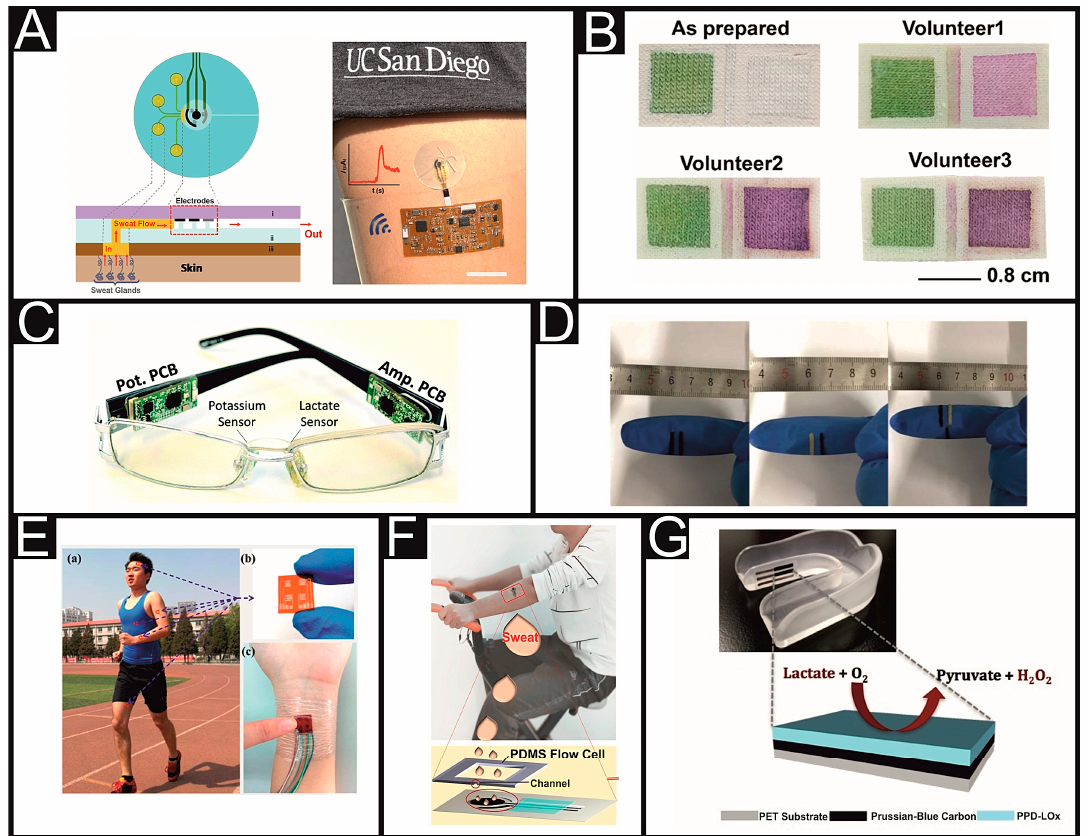
Figure 3. ( A ) Schematic representation and picture of the microfluidic device for the detection of lactate in sweat. Repro- duced/adapted with permission from ref. [95]. Copyright 2017 American Chemical Society. ( B ) Textile-based colorimetric sensor before and after testing on three human volunteers. Reproduced/adapted with permission from ref. [96].